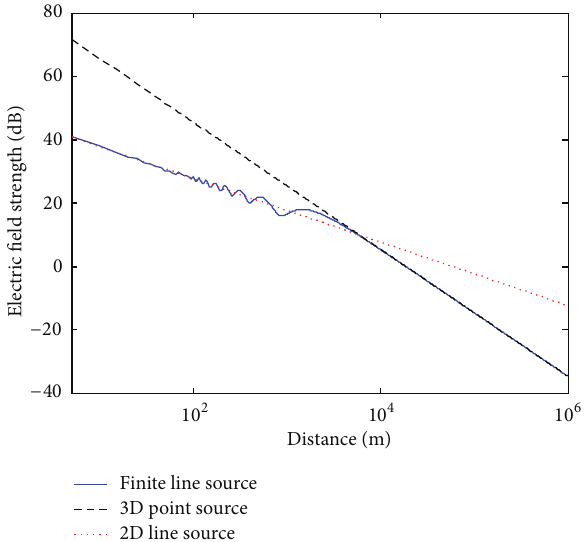
Figure 4: Electric field strength versus distance from a finite 64.5 m linecurrentat500 MHz.Thefieldstrengthsofaninfinitelinecurrent and an infinitesimal point current are overlaid, respectively, in red dotted and black dashed lines for comparison.